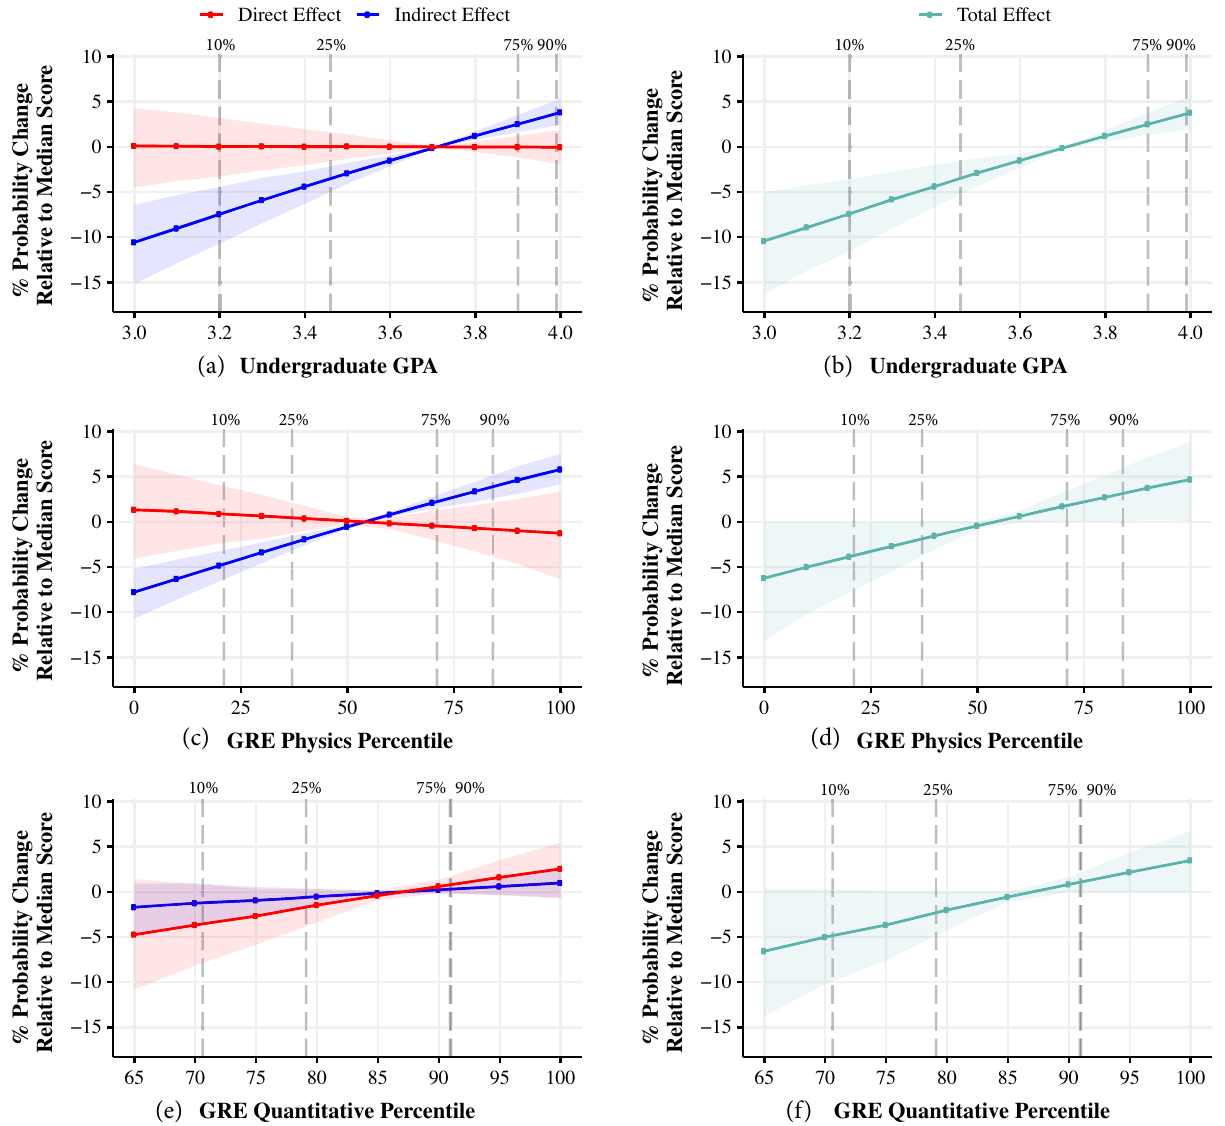
FIG. 4. Mediation analysis results predicting a student ’ s change in probability of completion, split into direct (red) and indirect via graduate GPA (blue) effects. Points on each plot represent individual calculations of probability change relative to each admission metric ’ s median value. 95% confidence intervals are indicated by the shaded region around each line; hence, if the shaded region contains the line y ¼ 0 , the effect is not statistically significant at the α ¼ 0 . 05 level. The median value of the x -axis variable is clearly shown on the plot as the point where the direct and indirect effect lines intersect, corresponding to a total probability change of 0%. The total effect of UGPA as well as the indirect effects associated with UGPA and GRE-P are statistically significant across all magnitudes of score